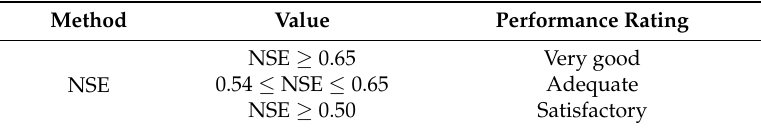
Table 3. Reported performance ratings for NSE statistics [51].